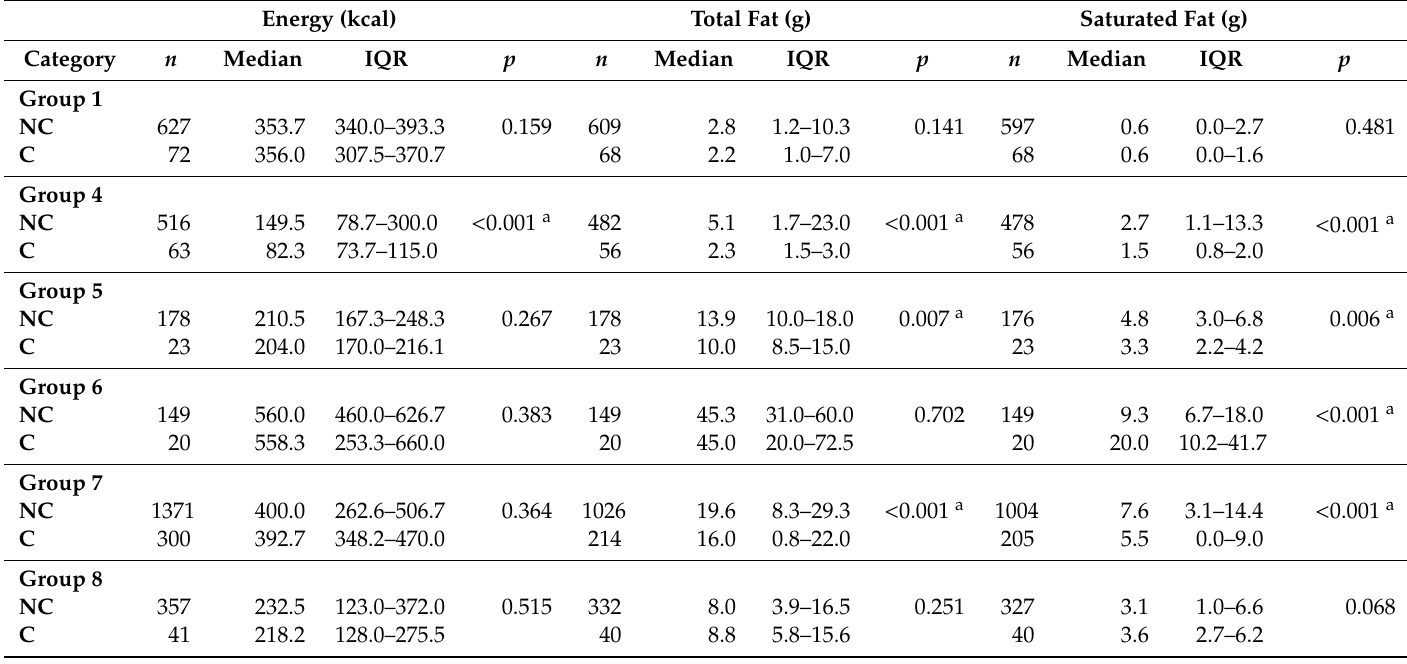
Table 3. Comparison of energy, and total and saturated fat content per 100 g of children’s (C) ( n = 535) and non-children’s (NC) ( n = 3628) food